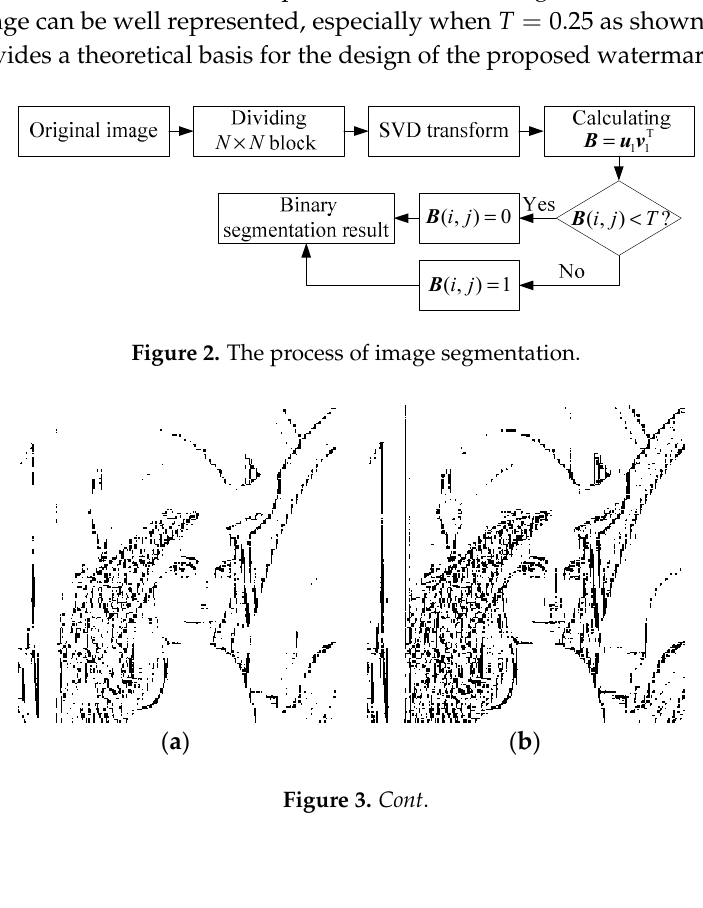
4 N = . In the 4 N = . In the